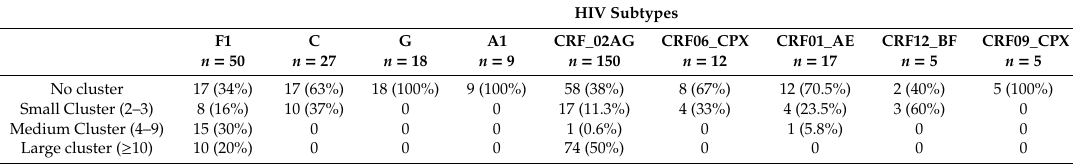
Table 2. Distribution of HIV-1 infected patients according to the di ff erent HIV-1 non-B subtypes and their clustering